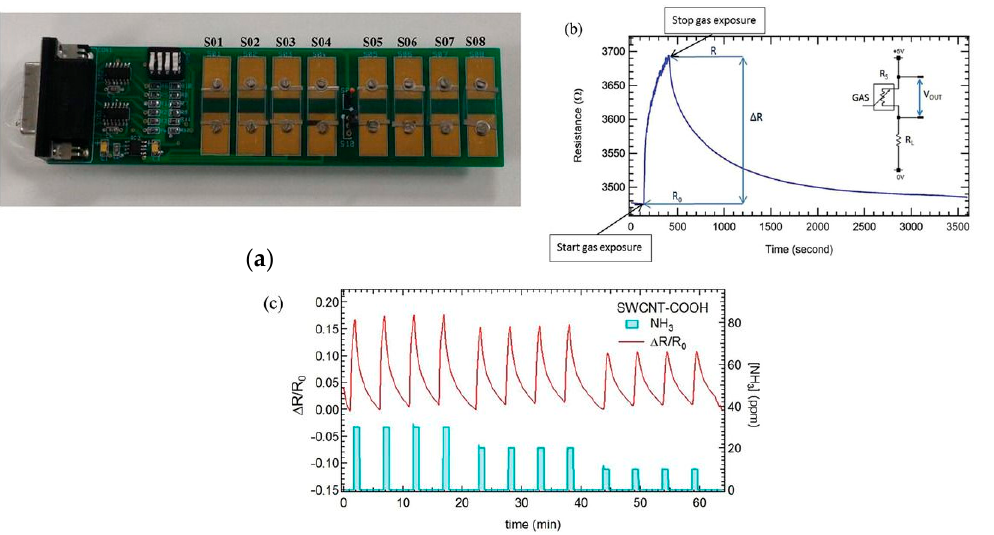
Figure 2. ( a ) Sensor array board of eight sensors based on single-walled carbon nanotubes (SWCNTs) functionalized with various organic molecules (S01:DNA, S02: PANI, S03: TCTA, S04: TAPC, S05: PTCDA, S06: ex-4T-Hex, S07: COOH, SO8: CNT); ( b ) Change of resistance of p-doped CNTs to ammonia; ( c ) Sensors response ∆ R/R 0 for CNT-COOH sensor followed by a sequence of four exposures to 30, 20, and 10 ppm NH 3 [23]. With the permission of John Wiley and Sons.